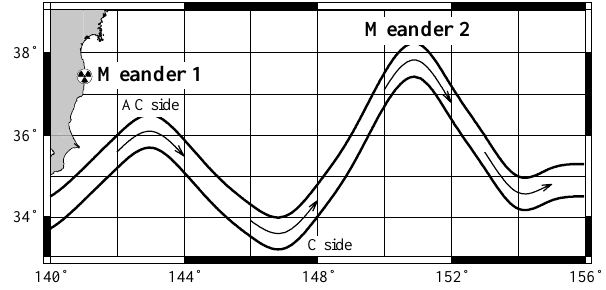
Fig. 1. Schematic view of the Kuroshio Extension state with two quasistationary meanders. Location of the Fukushima Nuclear Power Plant is